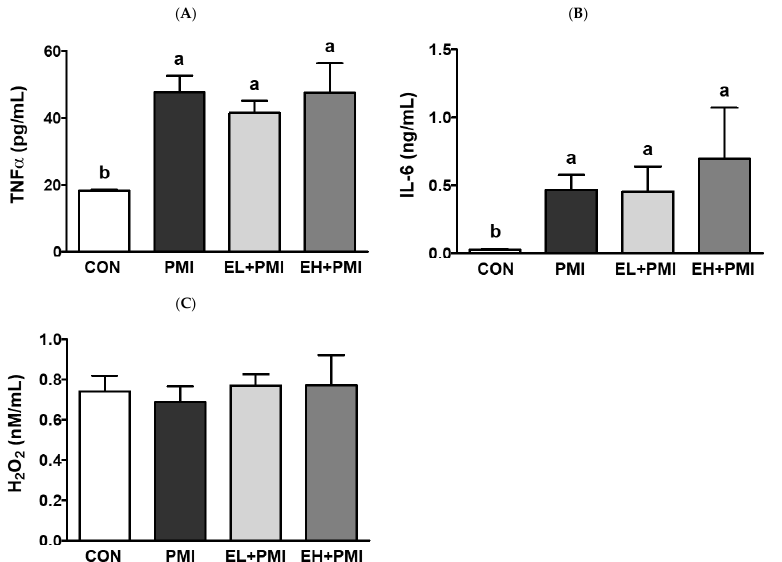
Figure 4. Inflammatory cytokine and H 2 O 2 levels in the BALF after ellagic acid (EA) pretreatment and particulate matter (PM) instillation. C57BL/6 mice were orally pretreated with ellagic acid (EL; 20 mg/kg or EH; 100 mg/kg) for 7 days, and then PM (5 mg/kg) was intratracheally administrated for 7 days with or without ellagic acid pretreatment: ( A ) TNFα, ( B ) IL-6, and ( C ) H 2 O 2 levels in the BALF. Values represent the mean ± standard deviation (SD) for each group ( n = 8). Data passed the D’Agostino and Pearson omnibus normality test; one-way ANOVA with Tukey’s post hoc test was applied. Lowercase letters indicate significant differences. p < 0.05.